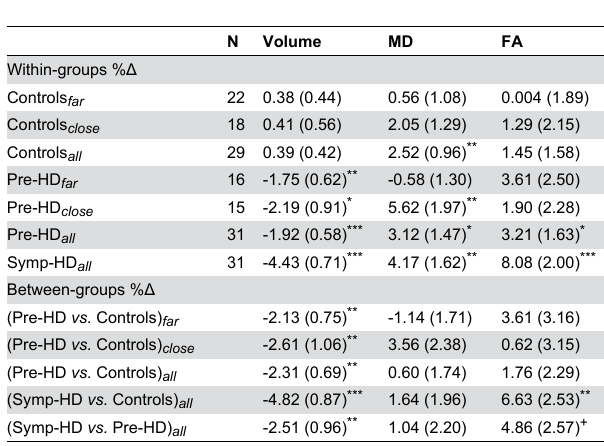
Table 2. Within- and between-group longitudinal rate of change in caudate volume, FA and MD in controls, pre-HD and